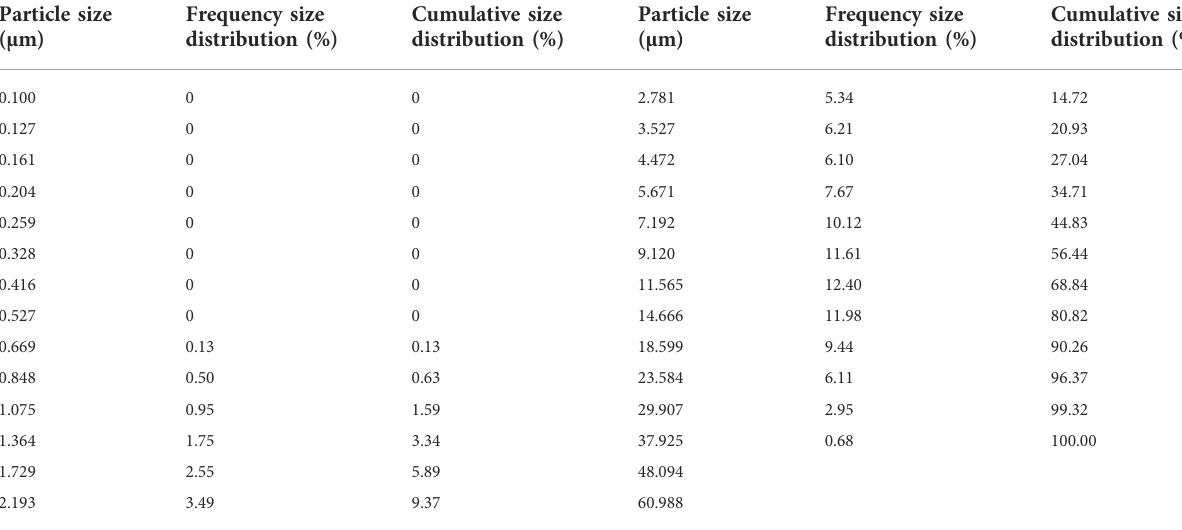
TABLE 2 Particle size distribution of K700 super fi ne cement.